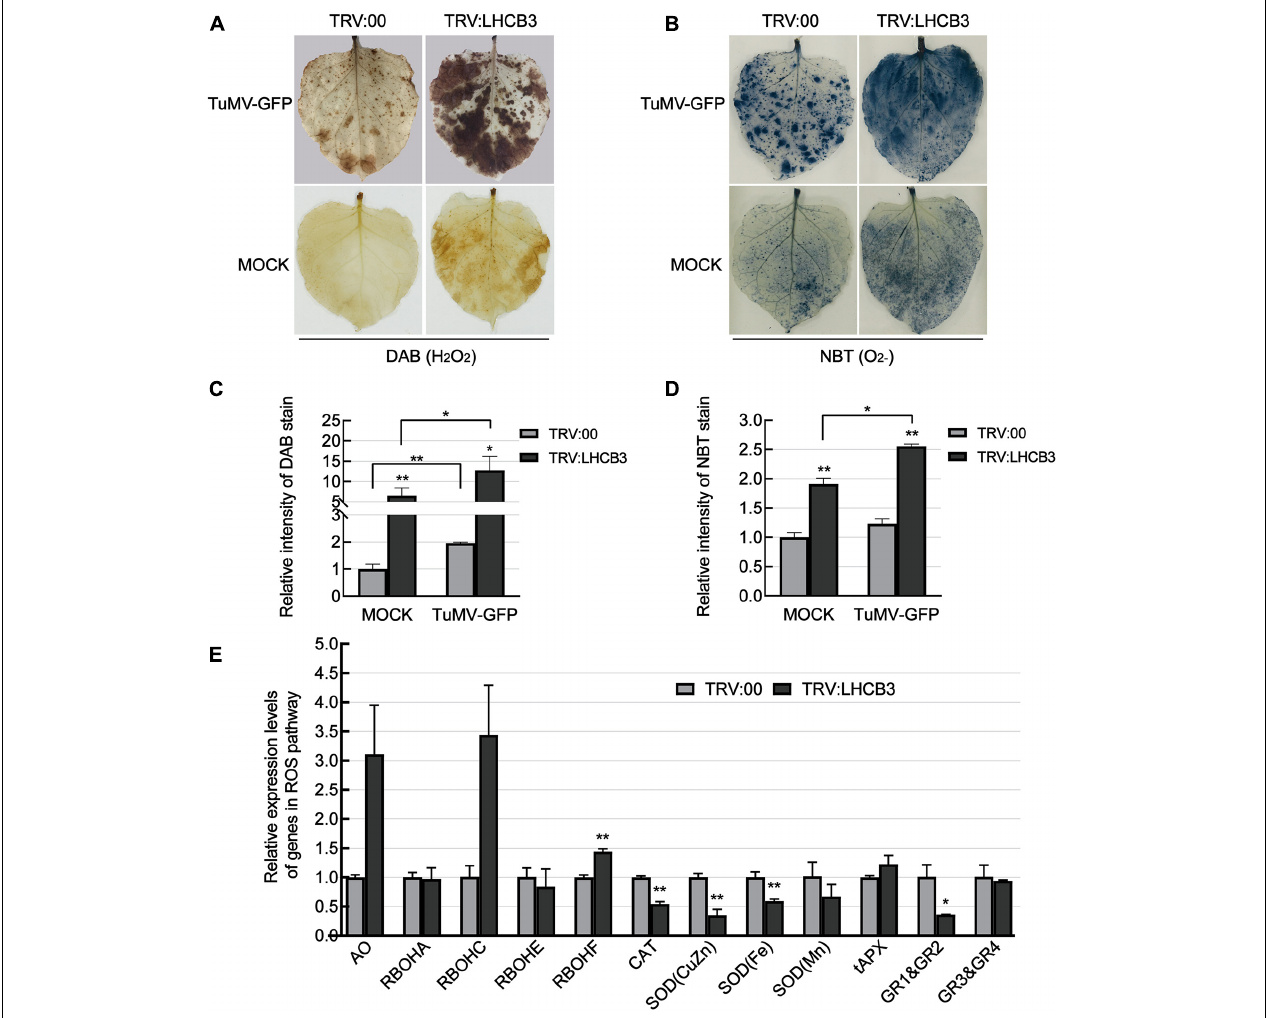
FIGURE 3 | Reactive oxygen species accumulated in the NbLHCB3 -silenced plants. (A) Detection of H 2 O 2 by DAB staining in plants inoculated with TRV:LHCB3 or TRV:00 with or without TuMV infection. (B) Detection of O 2 − by NBT staining in the plants inoculated with TRV:LHCB3 or TRV:00 with our without TuMV infection. (C) The relative DAB stain intensity of the NbLHCB3 -silenced and control plants. (D) The relative NBT stain intensity of the NbLHCB3 -silenced and control plants. (E) Identification of transcriptional levels of genes in ROS production and scavenging pathways. The relative DAB and NBT stain intensity was quantified by IMAGE J software. Bars represent the standard errors of the means from three biological repeats. A two-sample unequal variance directional Student’s t -test was used to test the significance of the differences (* P < 0.05; ** P < 0.01).